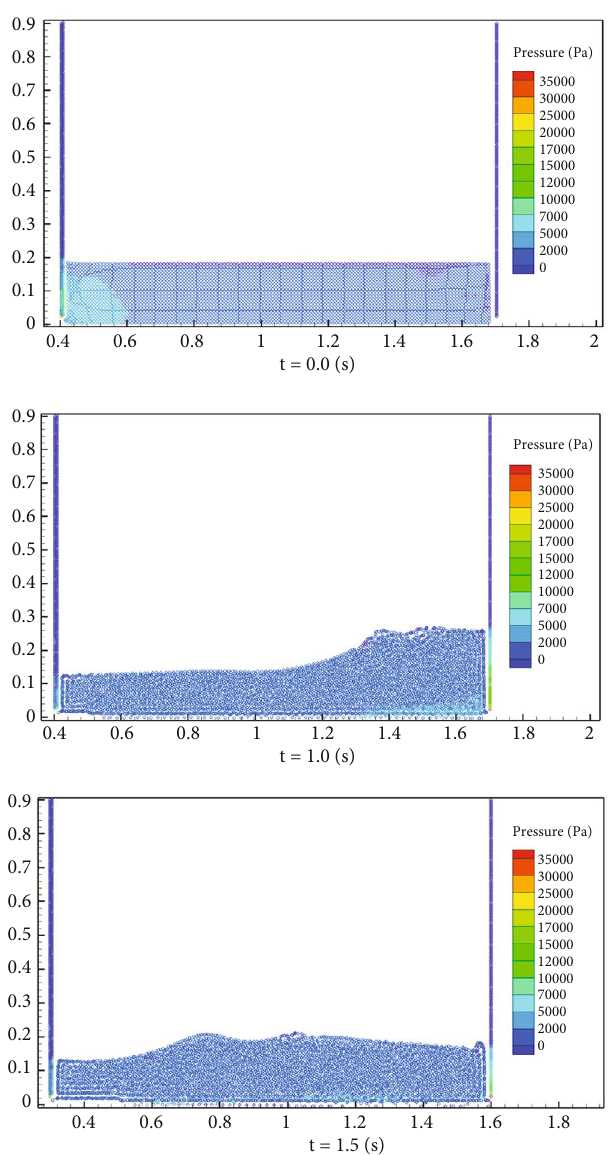
Figure 7: Simulation of fl uid sloshing in a rectangular